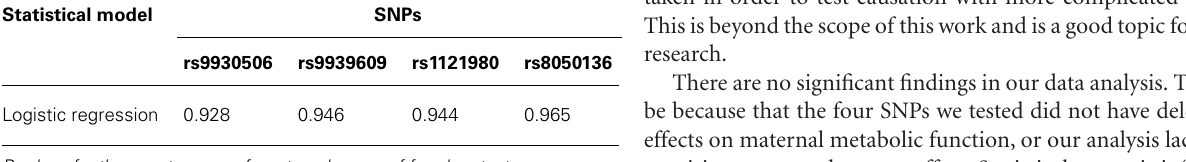
Table 2 | P -values of children’s genotypes from the analyses with only the first child in each family. Statistical